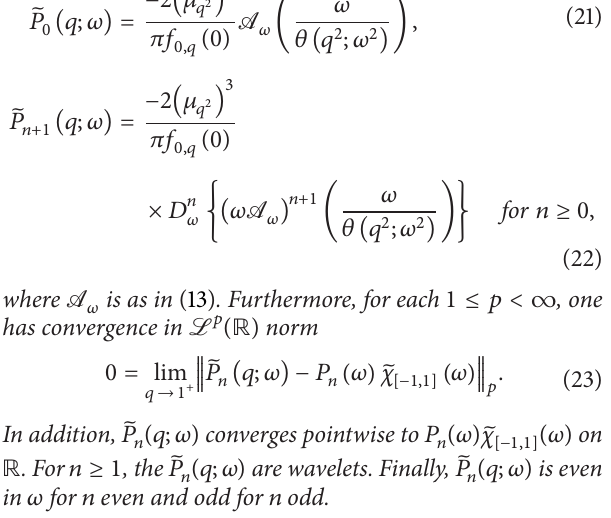
(𝑞;𝜔) is shown in solid for 1 (𝜔)̃𝜒 (𝜔) 2 [−1,1]